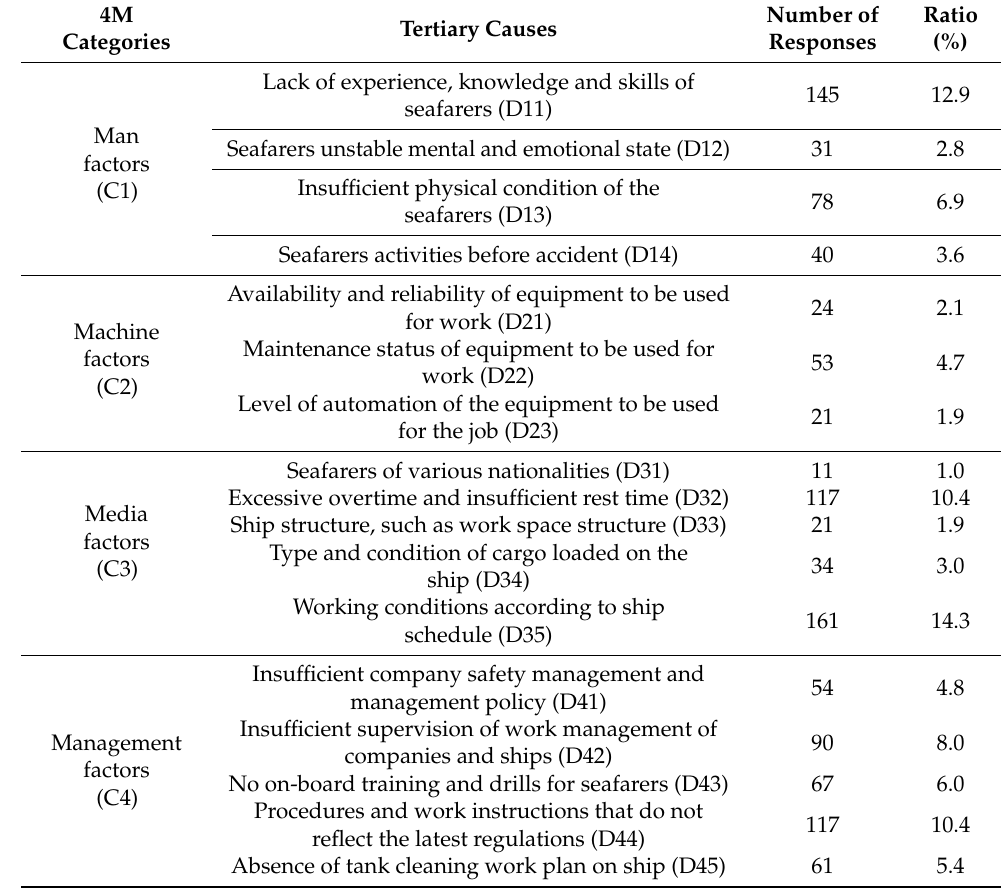
Table 3. The results of the questionnaire on tertiary causes of explosion accidents, owing to unsafe tank atmosphere